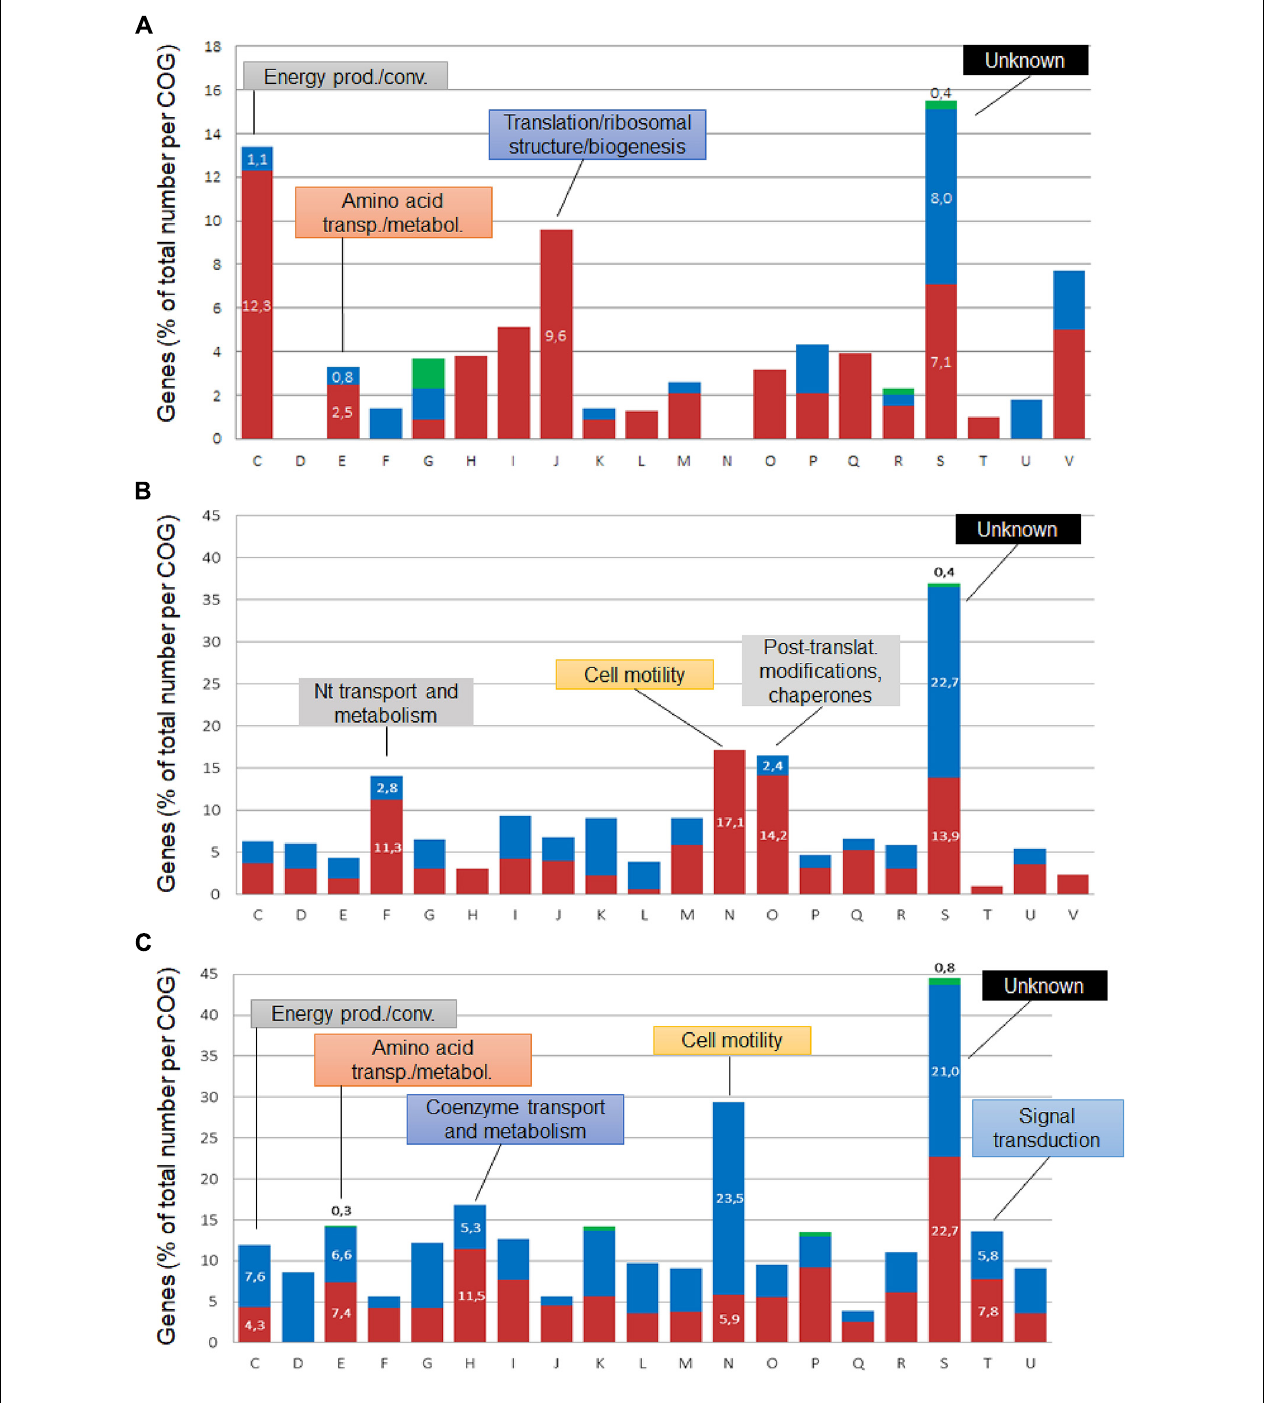
FIGURE 4 | COG classification of Brucella genes regulated at pH 4.5. The differentially expressed core genes (A) and those specific to B. suis (B) and B. microti (C) cumulated for both 20 and 120 min were classified into Clusters of Orthologous Groups, and their percentages were determined with respect to the total number of genes affiliated to each group. Blue sections of the bars represent genes with higher expression at pH 7, red sections genes with higher expression at pH 4.5, and green sections correspond to genes with opposite expression over time. COGs: C: Energy production/conversion; D: Cell cycle control, cell division; E: amino acid transport/metabolism; F: Nucleotide transport/metabolism; G: Carbohydrate transport/metabolism; H: Coenzyme transport/metabolism; I: Lipid transport/metabolism; J: Translation/ribosomal structure/biogenesis; K: Transcription; L: Replication, recombination/repair; M: Cell wall/membrane/envelope biogenesis; N: Cell motility; O: Posttranslational modification/protein turnover/chaperones; P: Inorganic ion transport/metabolism; Q: Secondary metabolites synthesis/transport/catabolism; R: General function prediction; S: Function unknown; T: Signal transduction; U: Intracellular trafficking, secretion/vesicular transport; V: Defense